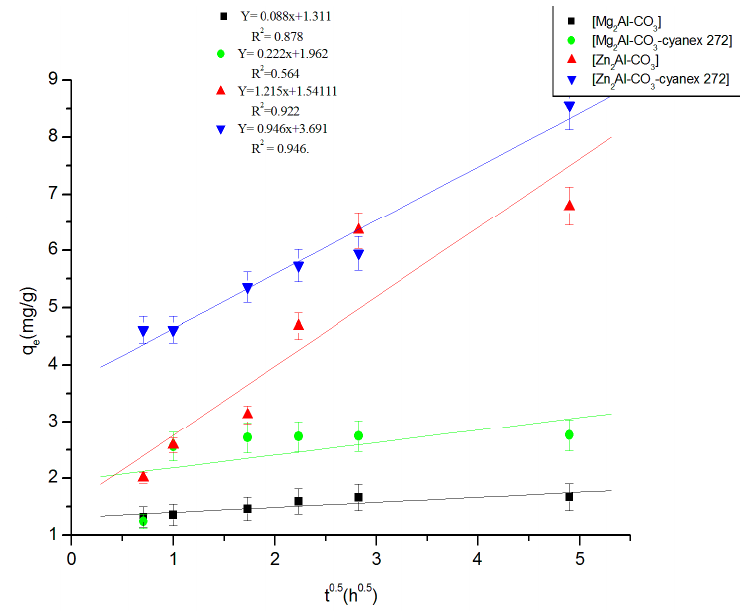
Figure 9. Kinetics of intraparticle diffusion of Zn (II) extraction.